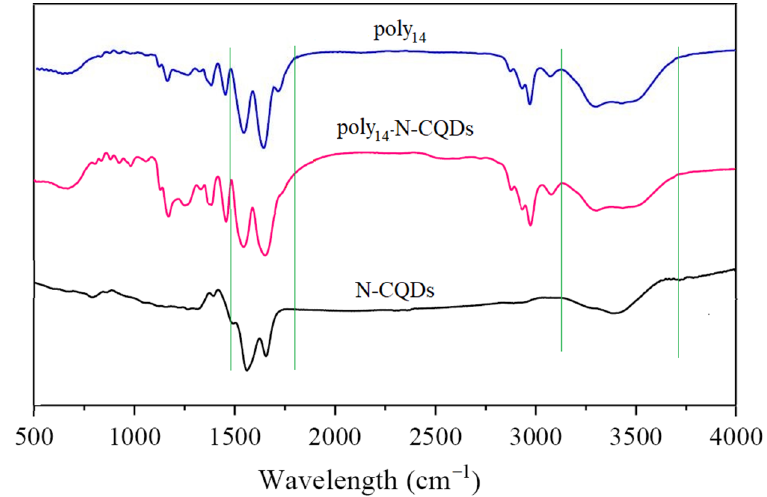
Figure 1. FT IR spectra of N-CQDs, poly 14 and poly 14 -N-CQDs.